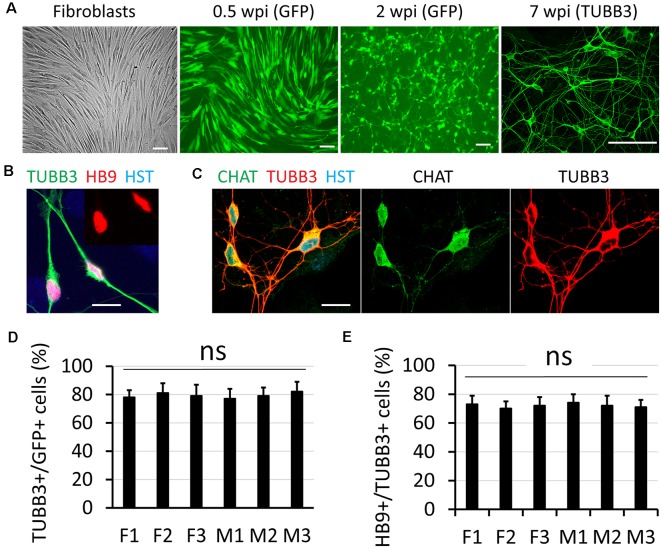
Direct conversation of adult human fibroblasts to motor neurons (MNs). (A) Micrographs of fibroblast and directly induced motor neurons (diMNs) at indicated weeks post viral infection (wpi). Transduced cells were identified with co-expressed green fluorescent protein (GFP) at early time points (0.5 and 2 wpi). Successfully converted neurons were identified by neuronal marker of tubulin beta 3 class III (TUBB3). Scale bars: 100 μm. (B) Confocal micrograph shows the highly expressed nuclear HB9 (motor neuron and pancreas homeobox 1, the early MN marker) at 2 wpi. The inset shows the nuclear HB9 alone. DNA dye Hoechst 33342 (HST) stained nuclei. Scale bar: 20 μm. (C) Confocal micrographs show the robust expression of the mature MN marker choline acetyltransferase (CHAT) at 8 wpi. Scale bar: 20 μm. (D) Quantification of the reprogramming efficiency was shown as the percentage of GFP (+) cells expressing TUBB3. More than 300 cells of each line were counted from triplicates. ns, not significant. (E) Fractions of diMNs among the reprogrammed neurons were shown as the percentage of TUBB3 (+) cells expressing HB9. More than 300 cells of each line were counted from triplicates. ns, not significant.